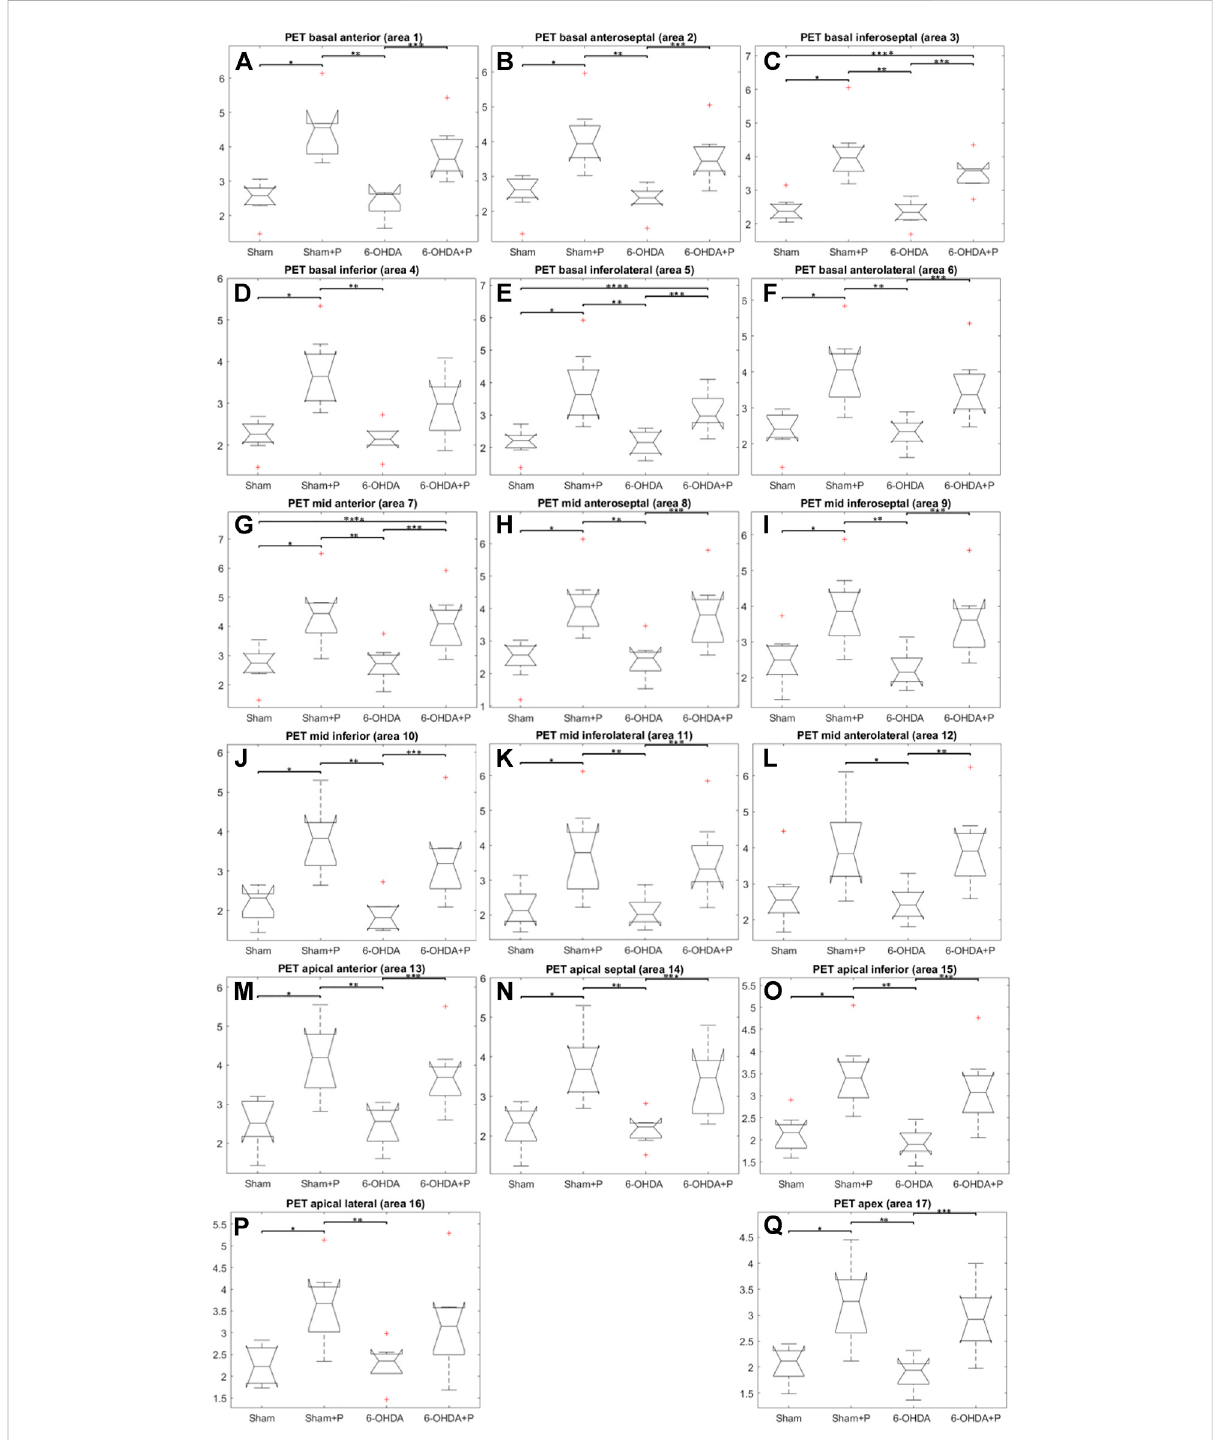
FIGURE 10 Comparison between the Sham, Sham + P, 6-OHDA and 6-OHDA + P groups of standardized [18F]FDG uptake value. (A) * p = 0.003; ** p = 0.0014; *** p = 0.028. (B) * p = 0.005; ** p = 0.0011; *** p = 0.013. (C) * p = 0.0011; ** p = 0.0014; *** p = 0.04; **** p = 0.037. (D) * p = 0.0044; ** p = 0.0008. (E) * p = 0.003; ** p = 0.0014; *** p = 0.011; **** p = 0.021. (F) * p = 0.006; ** p = 0.002; *** p = 0.013; (G) * p = 0.0078; ** p = 0.0078; *** p = 0.02; **** p = 0.02. (H) * p = 0.006; ** p = 0.0029; *** p = 0.014. (I) * p = 0.016; ** p = 0.0019; *** p = 0.013. (J) * p = 0.0074; ** p = 0.0011; *** p = 0.012. (K) * p = 0.012; ** p = 0.0043; *** p = 0.0084; (L) * p = 0.01; ** p = 0.0089. (M) * p = 0.009; ** p = 0.0048; *** p = 0.014. (N) * p = 0.014; ** p = 0.0027; *** p = 0.018. (O) * p = 0.007; ** p = 0.0009; *** p = 0.006. (P) * p = 0.006; ** p = 0.0014. (Q) * p = 0.01; ** p = 0.0008; *** p =